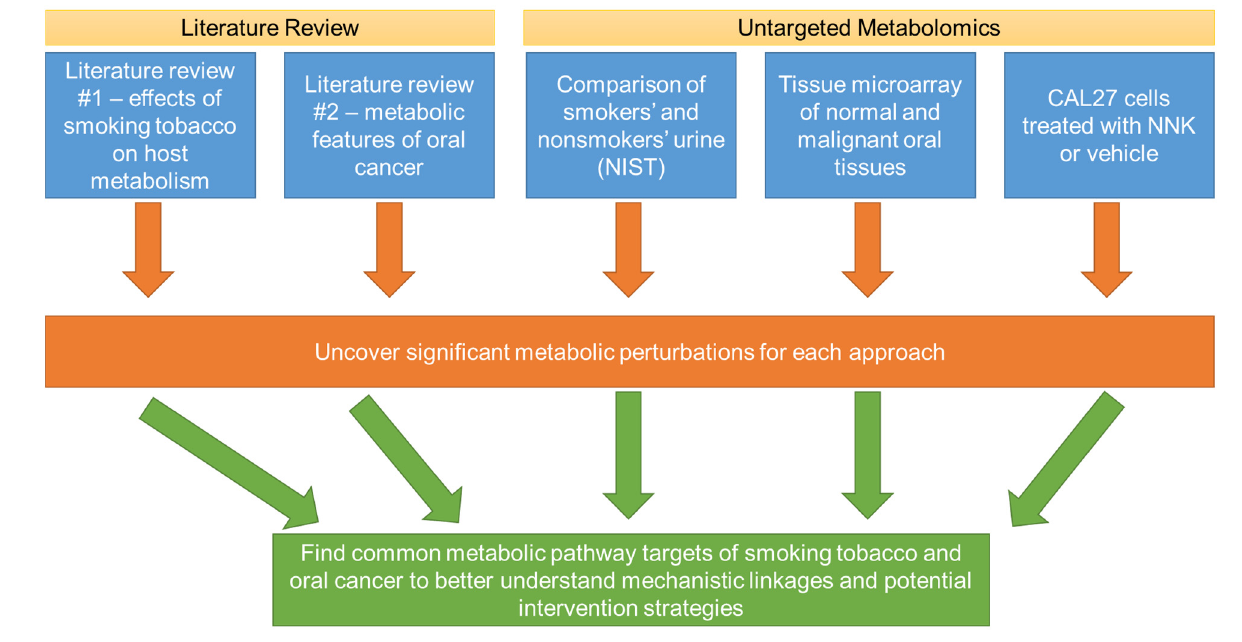
Figure 1. Overall workflow of the present study to identify commonalities of metabolic perturbations of smoking tobacco and oral cancer. Multiple strategies were utilized, including literature reviews and untargeted metabolomics investigations involving biospecimens for smokers and non-smokers, normal and malignant oral tissues, and an oral cancer cell line (CAL27) treated with a prominent tobacco carcinogen. Shared metabolic disruptions between these investigations are likely to reveal mechanistic insights to how smoking alters metabolism to lead to oral cancer, as well as potential metabolic targets to prevent or treat oral cancers that arise due to tobacco use.